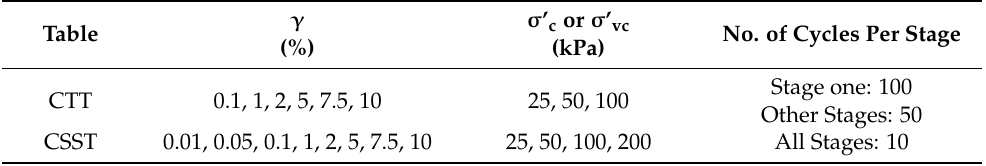
Table 1. Summary of the testing